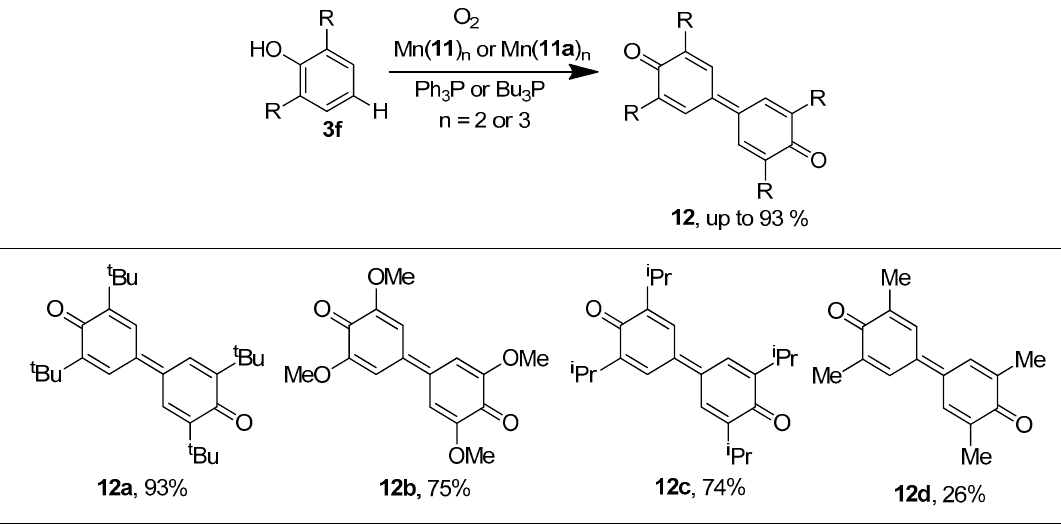
Yields refer to reported isolated compounds.